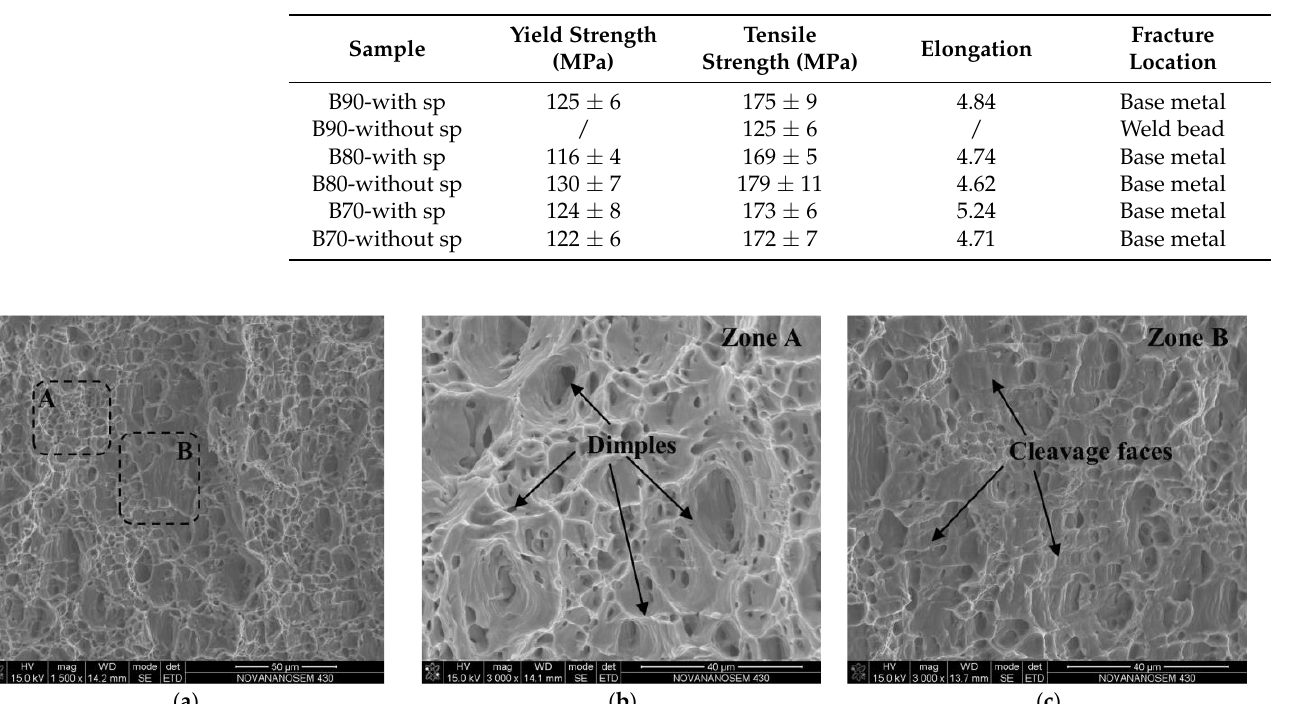
Figure 16. SEM image of the fracture surface for 204 J/mm with SP. ( a ) SEM image of the fracture surface; ( b ) Dimples on fracture surface; ( c ) Cleavage faces.